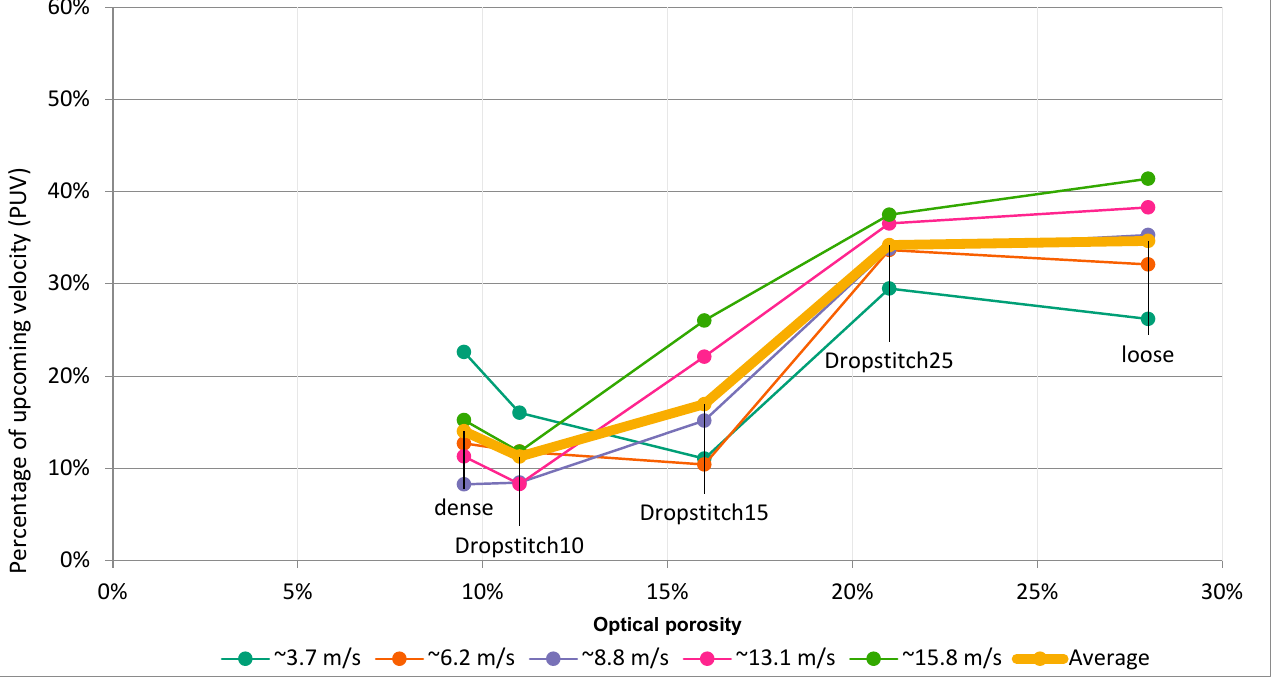
Figure 15. Percentage of upcoming velocity (PUV) depending on the calculated optical porosity, using the value for unstretched drop-stitch 10%.